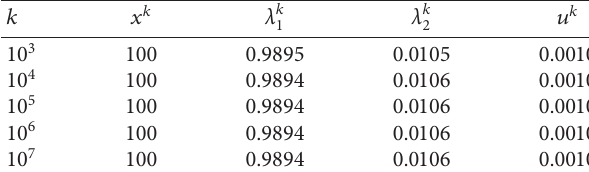
Table 1: Computational results for the problem